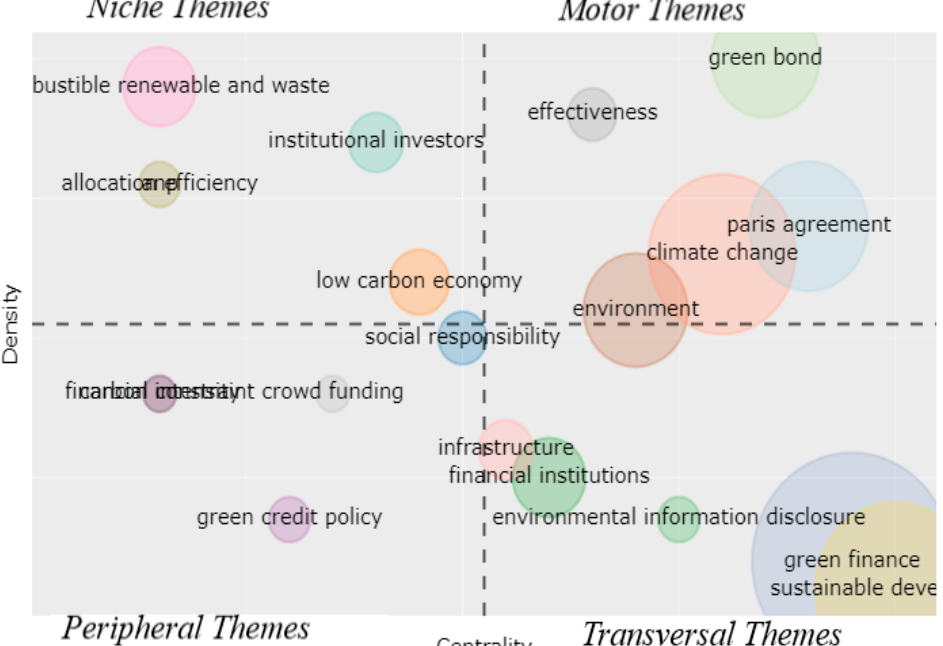
Figure 6. Thematic map of the journal (line 294).